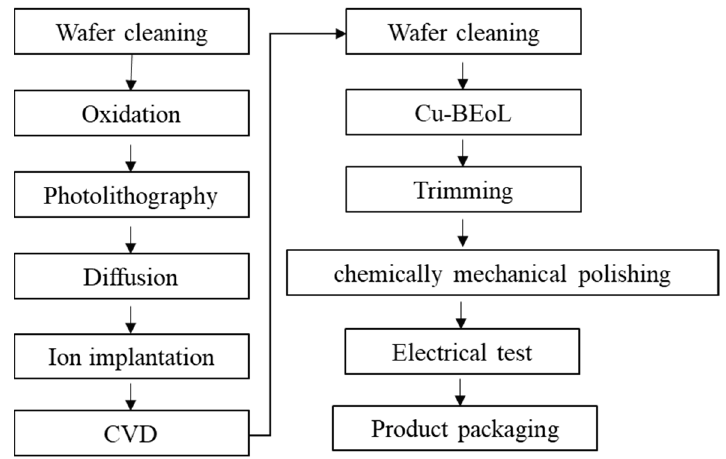
Figure 9. Process flow chart of a typical integrated circuits manufacturing enterprise. (Note: CVD: chemical vapor deposition, Cu-BEol: copper wiring).